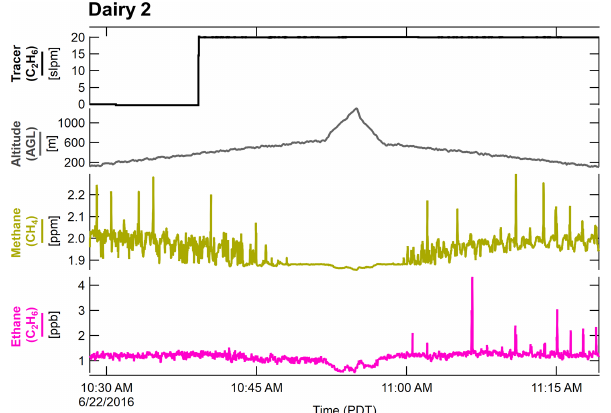
Figure 5. Comparison of flight sampling periods prior to and dur- ing release of tracer gas (ethane, C 2 H 6 ), showing enhancements of methane above Dairy 2 with and without corresponding peaks of